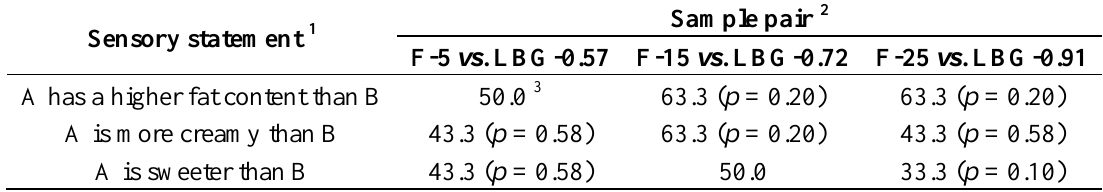
Table 3. Percentages of coinciding statements in two-alternate force tests ( n = 30) of three sample pairs with similar